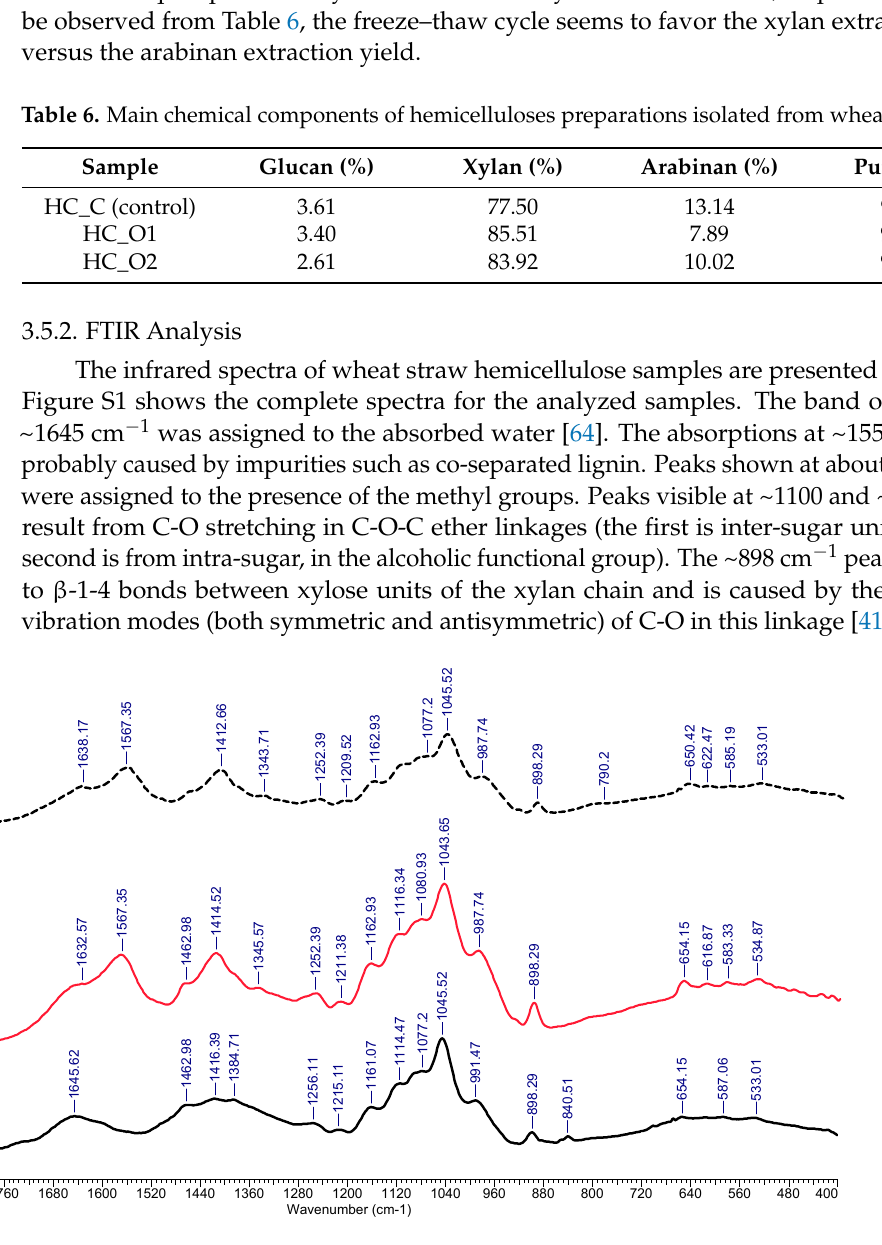
Figure 6. FTIR spectra of hemicelluloses separated from wheat straw by using different sequences.